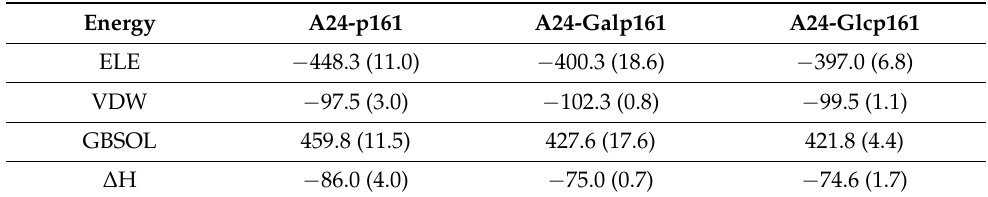
Table 3. Binding energies Δ H GBSA between the p161 peptides and A24 during the 300–500 ns phase of the MD simulations with the standard deviations in parentheses.